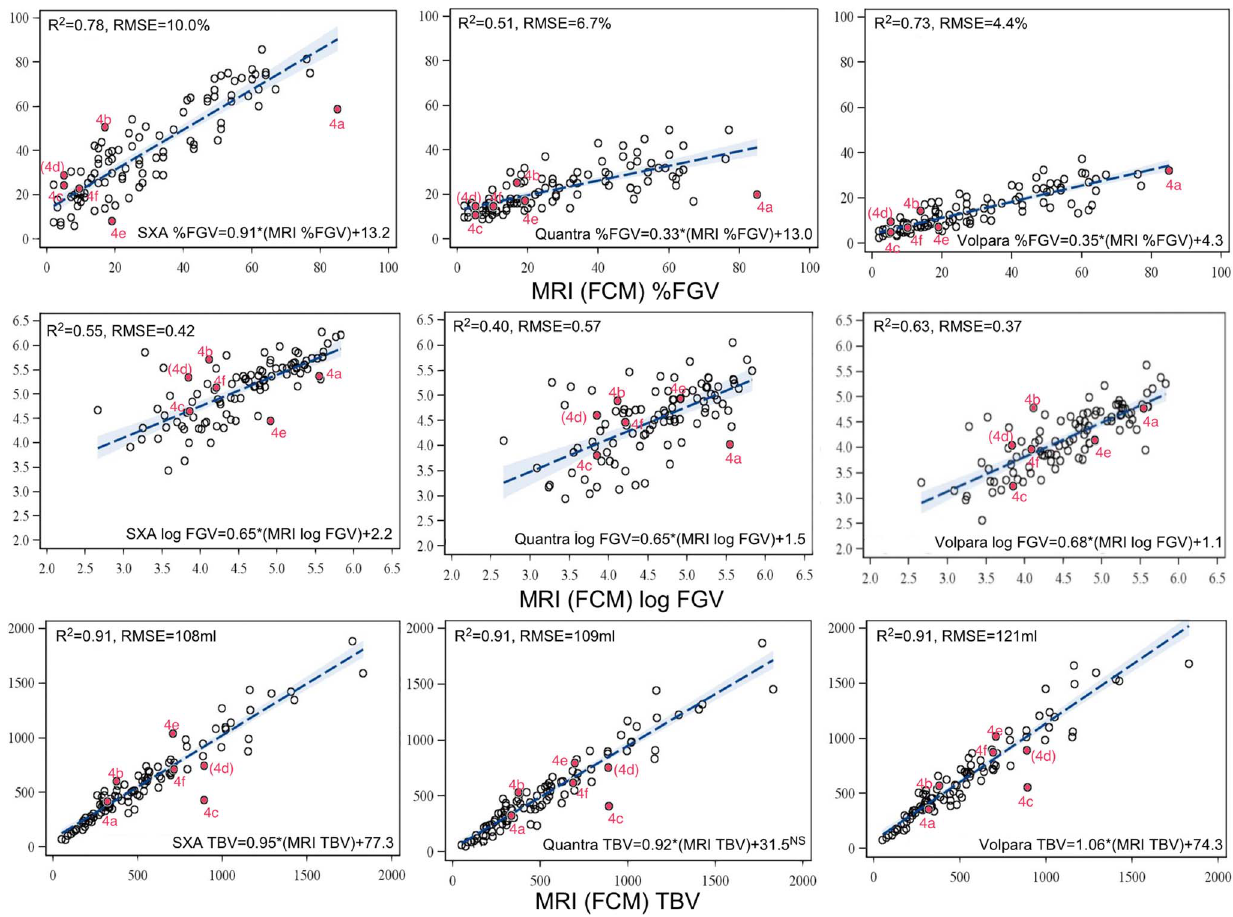
Figure 1. Best linear regression fit line with 95% confidence interval bands for percentage fibroglandular density (top), log fibroglandular volume (middle), and total breast volume (bottom) for MRI versus either SXA (left), Quantra (center), or Volpara (right) measures. Solid points correspond to example images in Figure 4. doi:10.1371/journal.pone.0081653.g001 PLOS ONE |